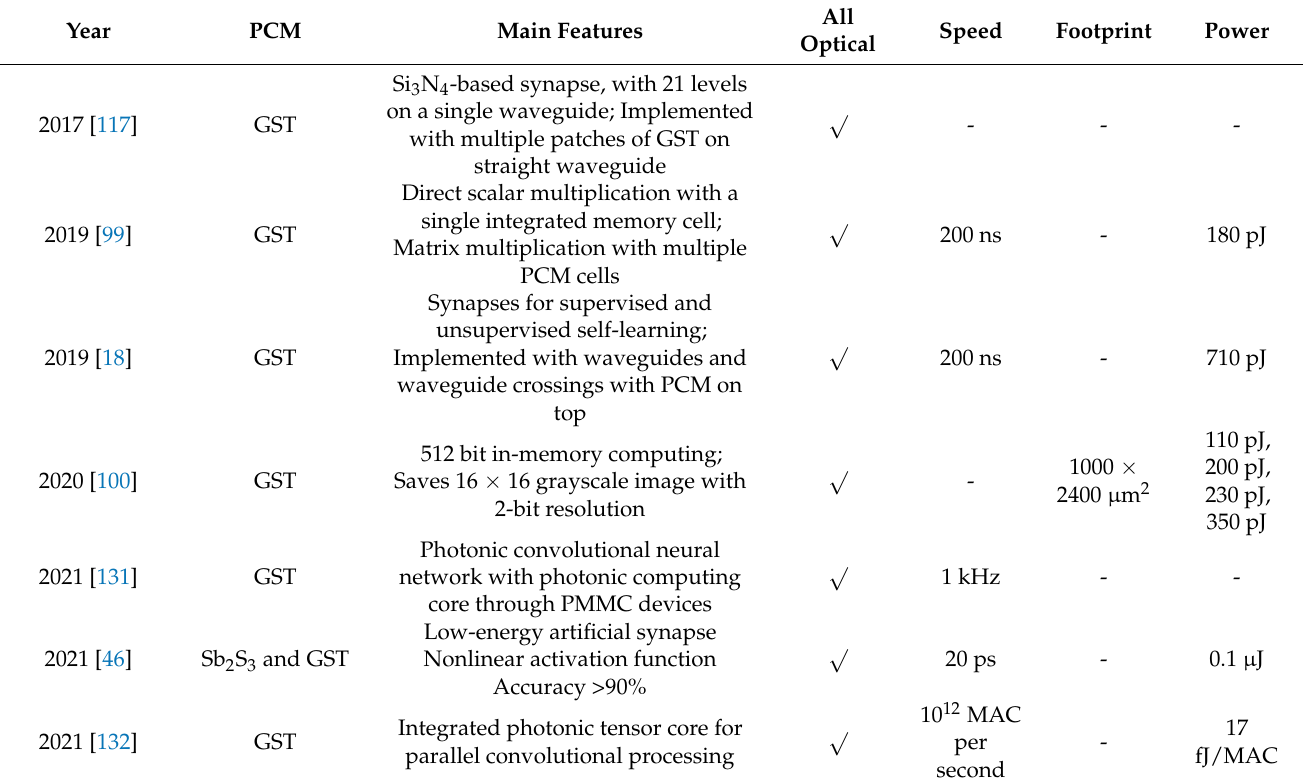
Table 4. Major contributions in neuromorphic/in-memory computational